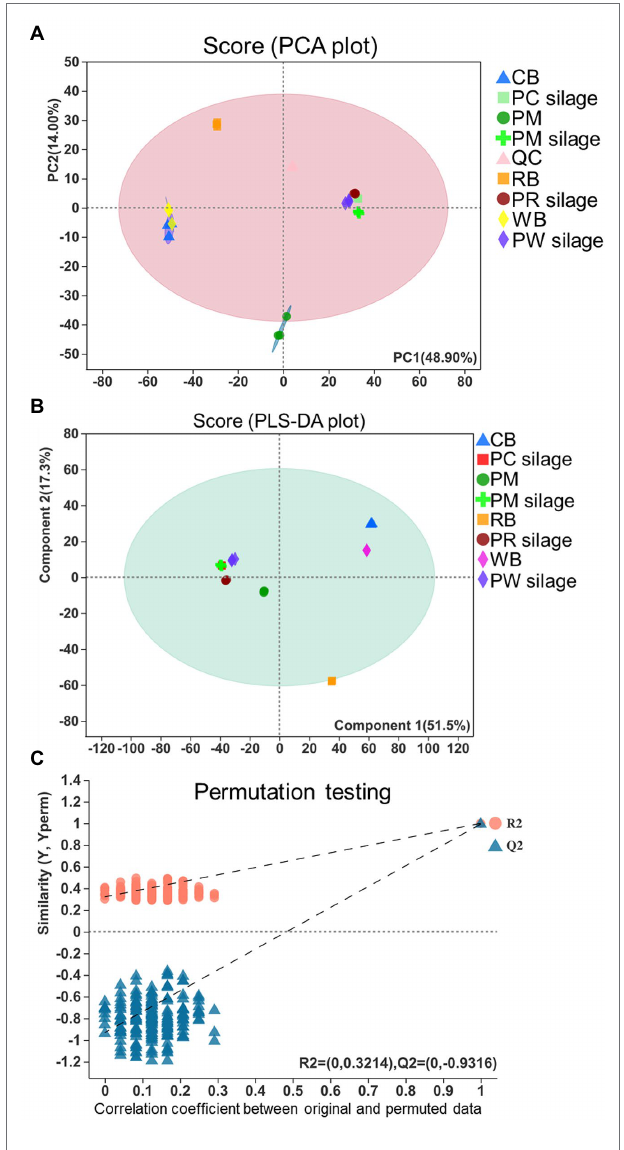
FIGURE 5 | PCA and PLS-DA score plots resulted from the metabolites PM, CB, RB, WB material, and their silage (A,B) and permutation tests of the PLS-DA model indicate the absence of over-fitting in the model (C) . PCA, principal component analysis; PLS-DA, partial least squares-discriminate analysis; PM, paper mulberry; CB, corn bran; RB, rice bran; WB, wheat bran; PC, PM + CB; PR, PM + RB; PW, PM + WB; QC, quality